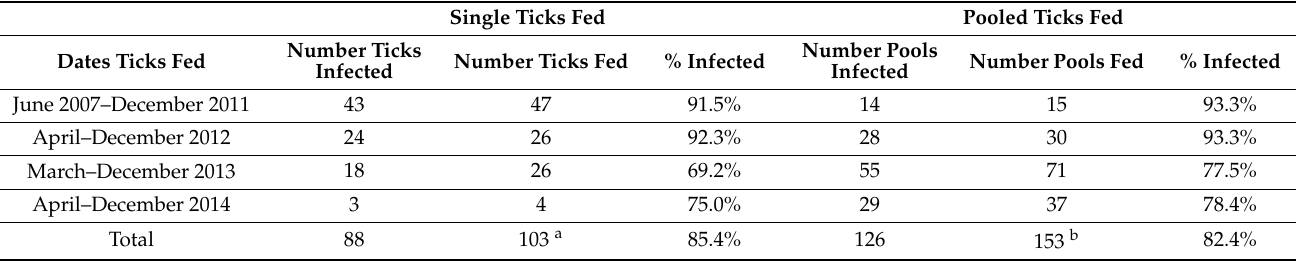
Table 4. Assessment of nymphal and adult O. hermsi infected with B. hermsii by feeding single and pooled ticks on mice at different times after tick colonization. Single Ticks Fed Pooled Ticks Fed Dates Ticks